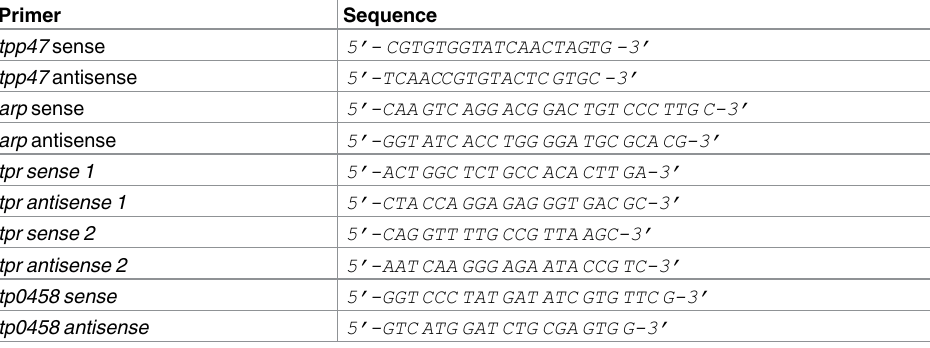
Table 1. Primers used in T . pallidum strain